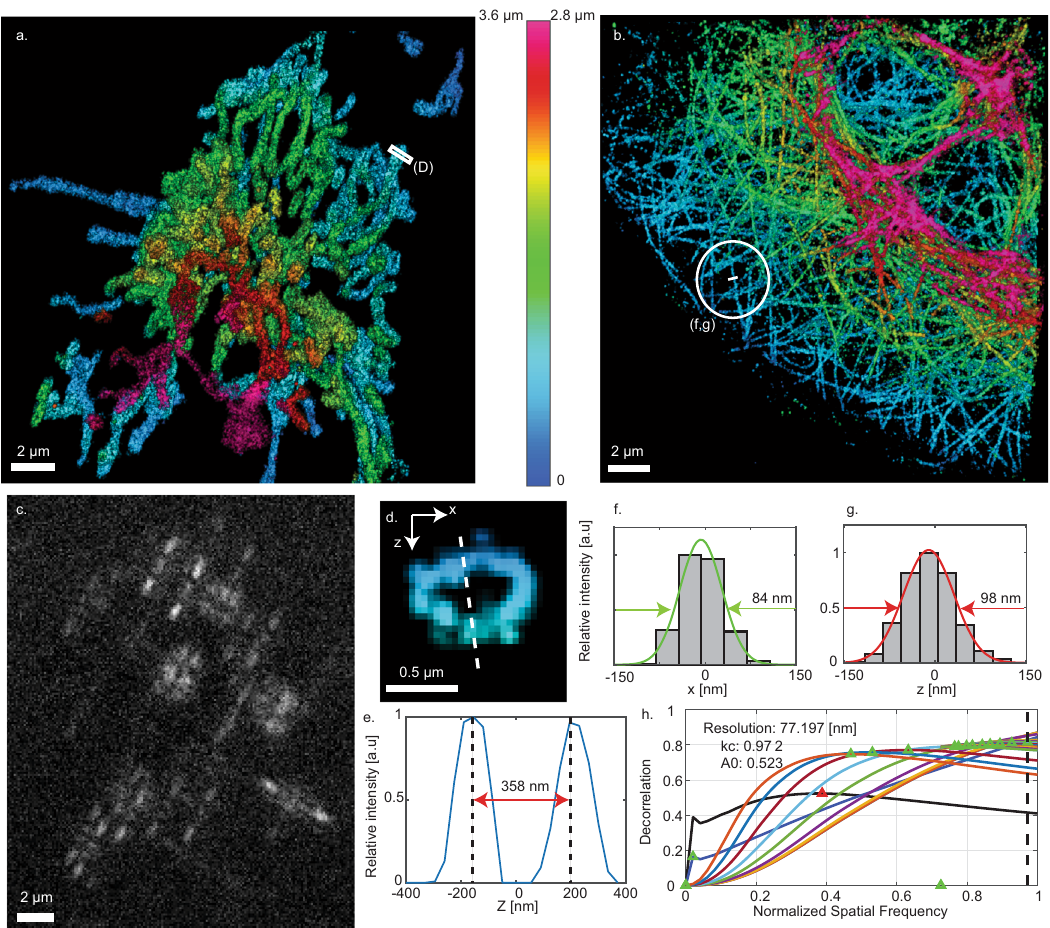
Fig. 3 The results of the STORM experiments. a , b Super-resolution reconstruction of mitochondria/microtubules in fi xed U2Os cells. c An example frame from the experimental raw data; different Z-positions, manifested by different PSF shapes, can be observed. d An example of the hollow structure of the mitochondria. e The intensity histogram of the X , Z hole-cross-section (shown in ( d )). f , g The intensity histogram of one line from the microtubules reconstruction in the lateral and axial directions respectively. h Parameter-free image resolution estimation based on decorrelation analysis 28 yielded ~77 nm lateral resolution. 3D illustrations of the reconstructed mitochondria/microtubules are shown in Supplementary Movies 1 and